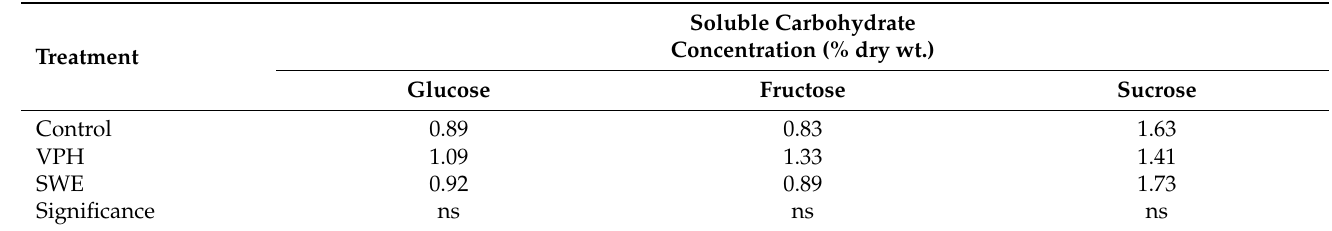
Table 6. Effect of biostimulant treatments on glucose, fructose, and sucrose concentration of chicory roots in the growth chamber